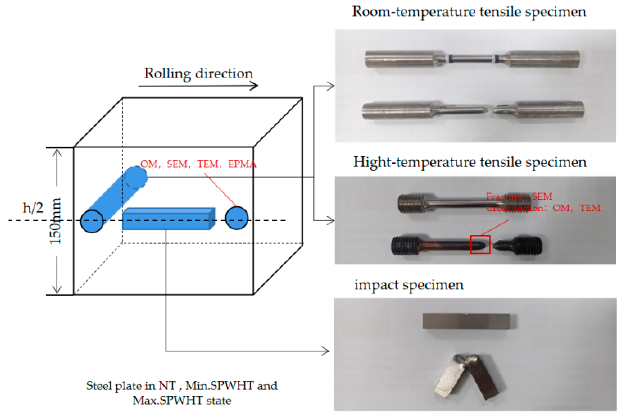
Figure 1. The sampling position and analysis method of the